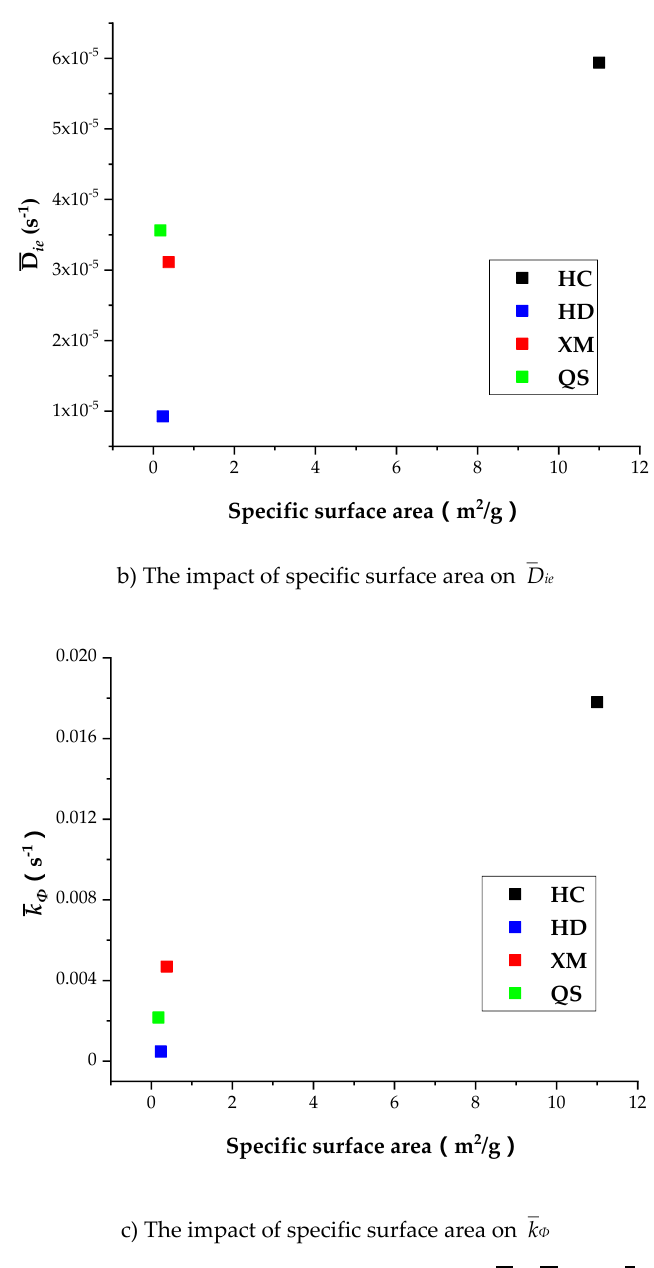
Figure 13. The impact of specific surface area on D ae , D ie , and k Φ.